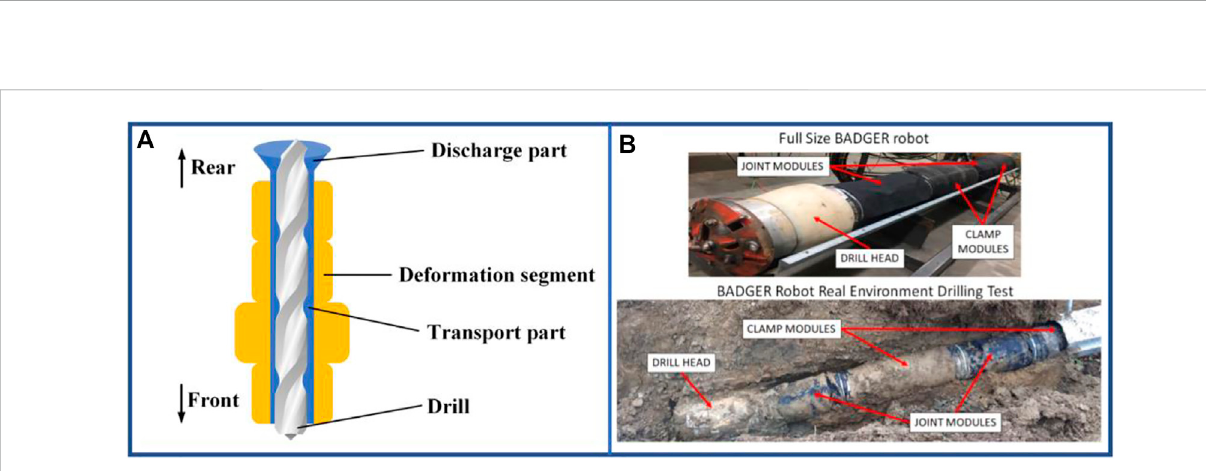
Frontiers in Bioengineering and